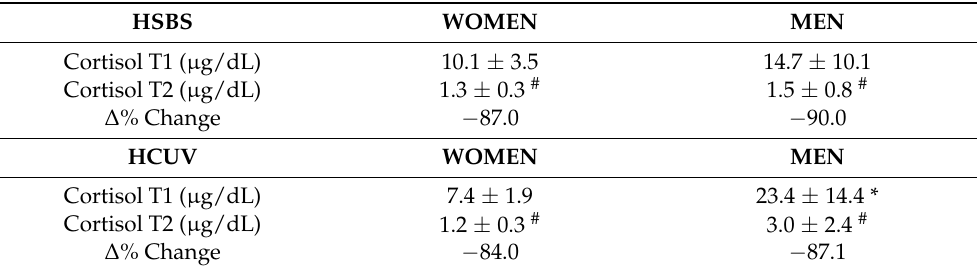
Table 3. Salivary cortisol, in men and women from both hospitals. The 95% confidence interval of the median, calculated by bootstrap, is shown.